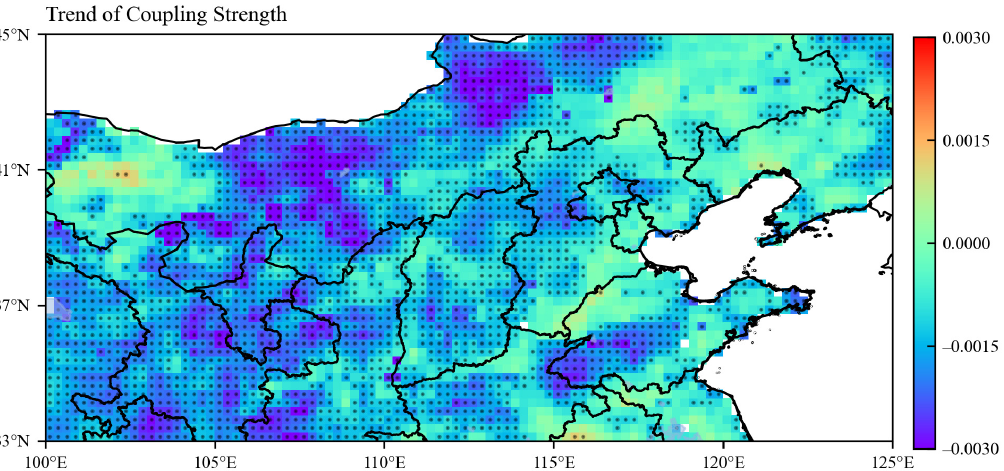
Figure 6. Decadal changes in spatial distribution of evapotranspiration–precipitation coupling in the climate transitional zone of northern China, ( a ) for 1980–1989, ( b ) for 1990–2000, ( c ) for 2000–2009, and ( d ) for 2010–2019 (dot denotes CS passing 0.05 significance test).